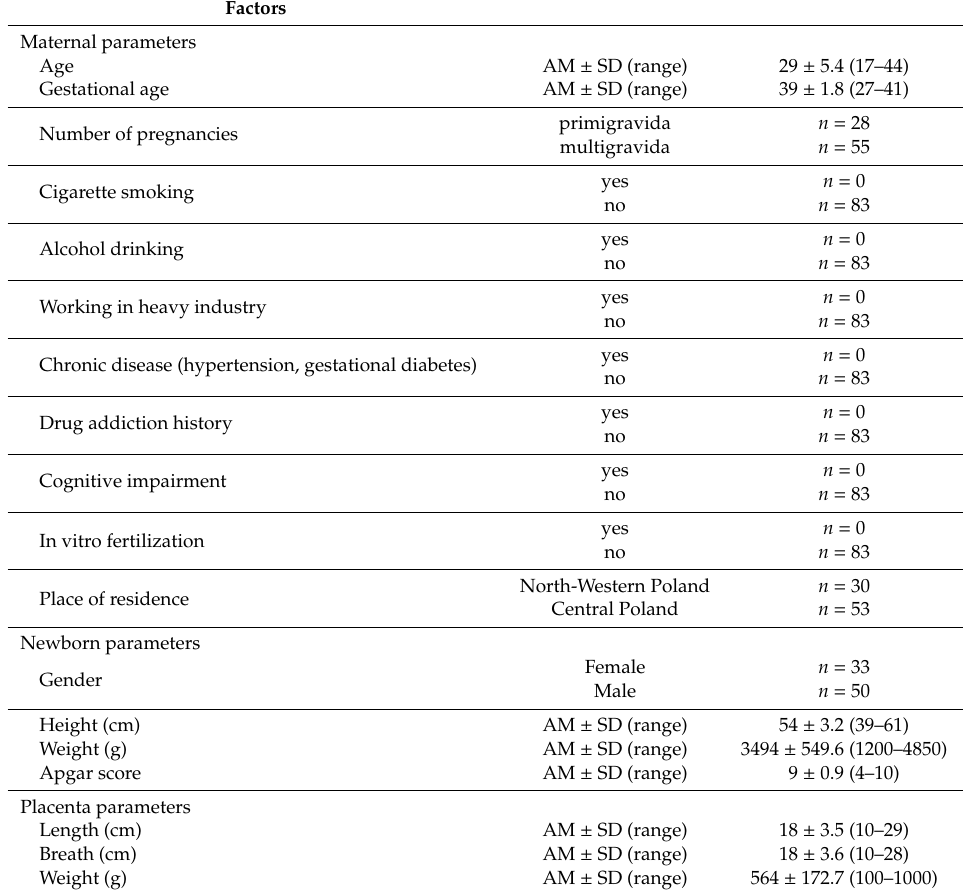
Table 1. Information on maternal, newborn and placenta parameters included in the study (AM, arithmetic mean; SD, standard deviation; n ,